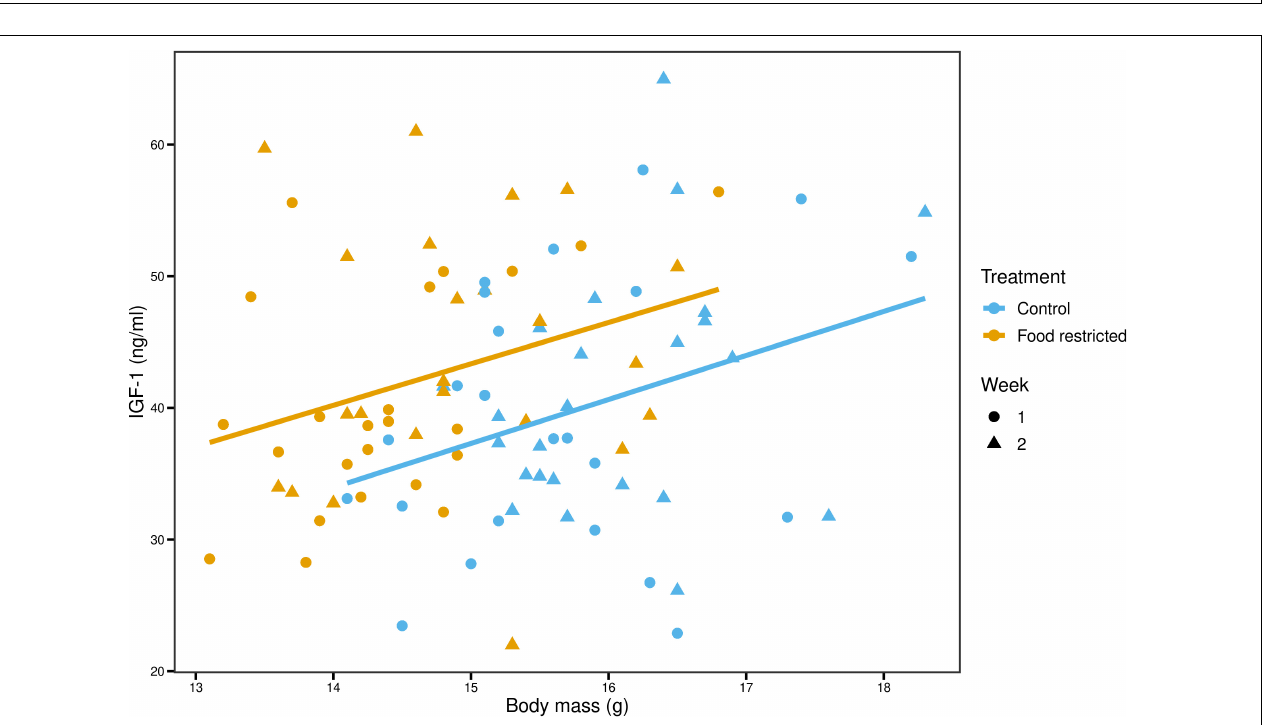
FIGURE 3 | Birds with higher average body mass have higher IGF-1 levels. Blue and orange solid lines show the among-individual relationships for control and food-restricted treatment, respectively.